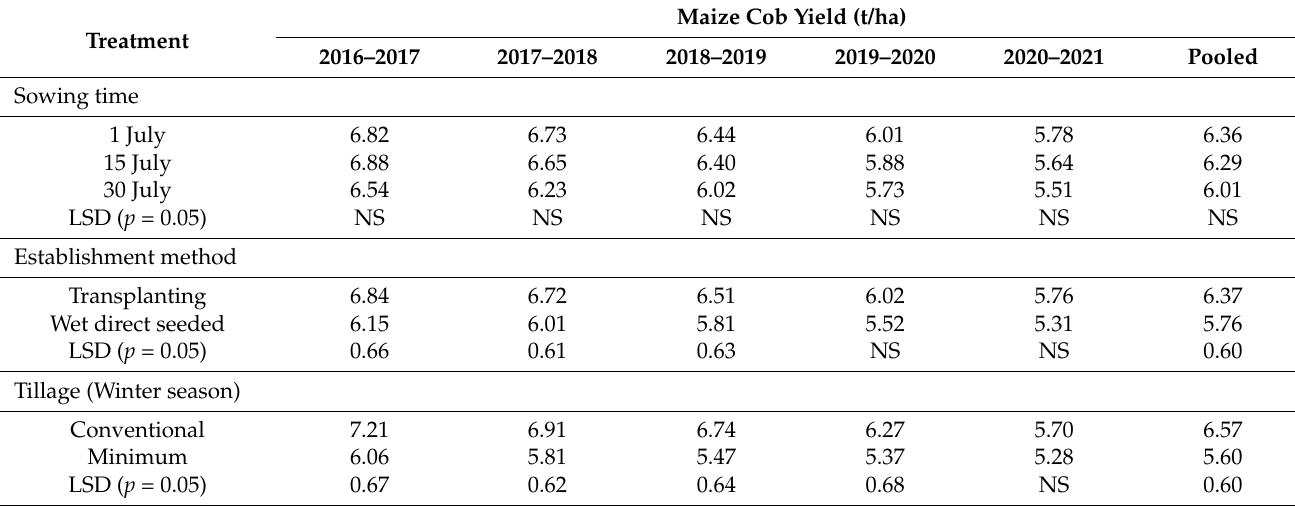
Table 3. Maize cob yield obtained under applied treatments during the 5-year period.